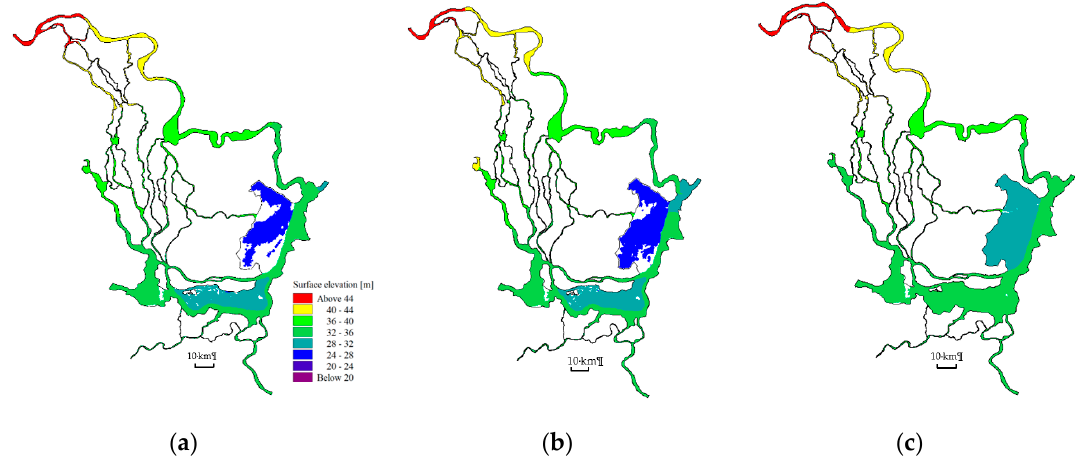
Figure 11. Water level distribution in Dongting Lake before the flood wave arrives in 1998. ( a ) 3 July; ( b ) 22 July; and, ( c ) 16 August. ( b ) 22 July; and, ( c ) 16